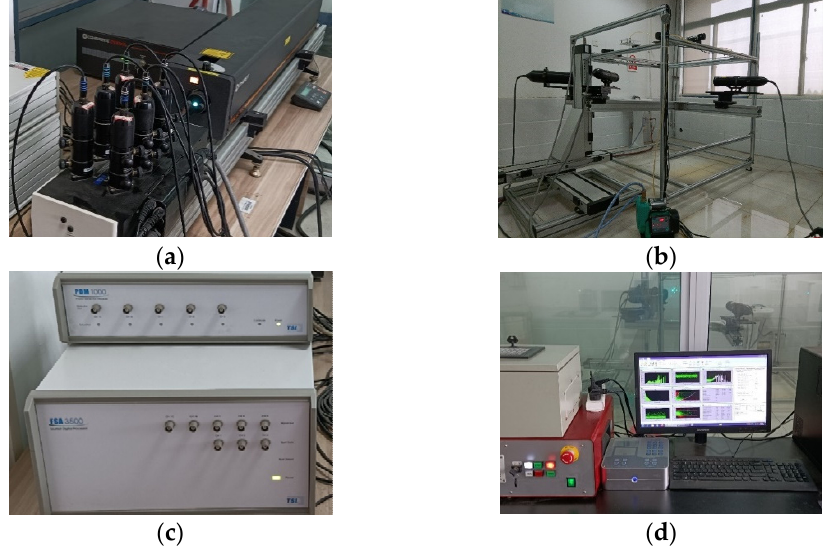
Figure 2. Test system: ( a ) laser and multicolor beam separator; ( b ) the transmitting probe and receiver along with 3DOF mobile platform; ( c ) signal processor; and ( d ) computer with the FLOWSIZETM software installed.